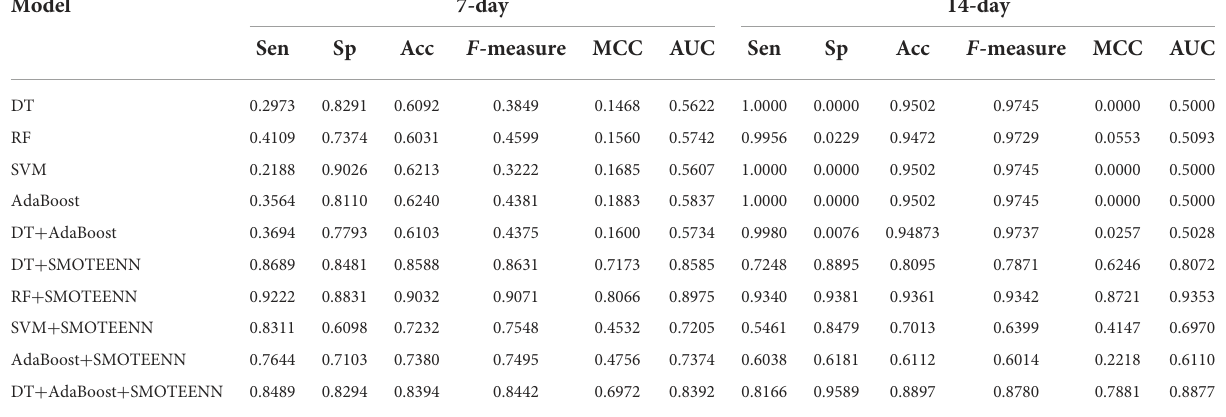
TABLE 3 Evaluation indices of the classification models for full variables.